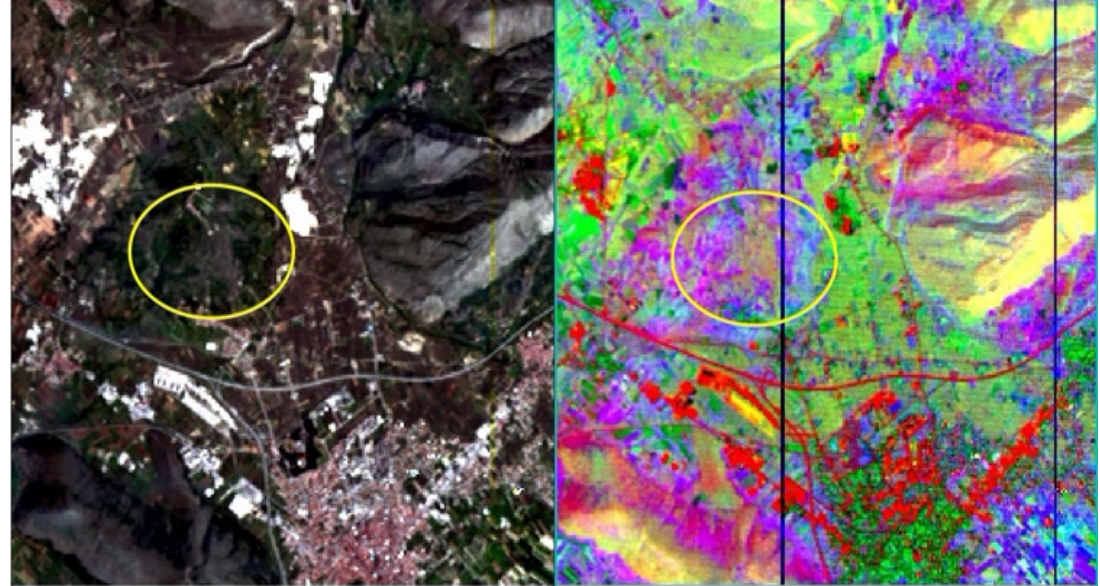
Figure 12. Alba Fucens’ PRISMA VNIR particular comparison referred to RGB (left) and PCA (right) image: in the highlighted central area it can be noted that the soil features are structurally different compared to the surrounding soils.